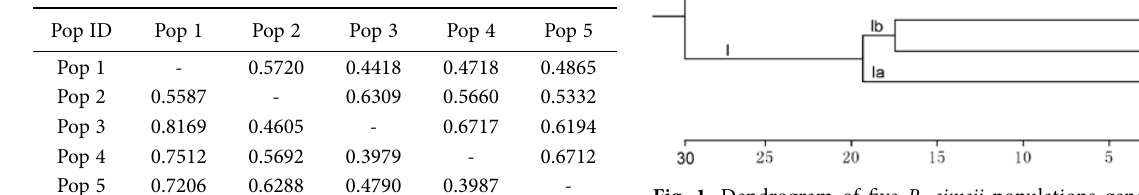
Fig. 1. Dendrogram of five R. simsii populations generated with MEAG4 cluster